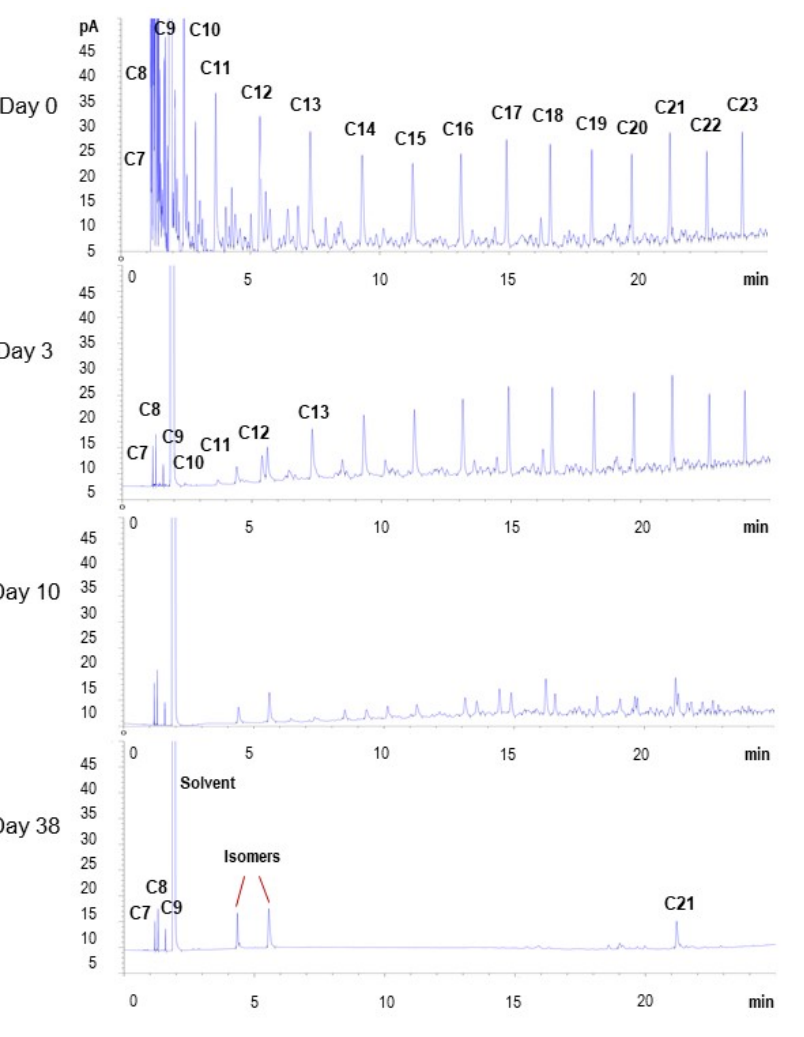
Figure 5. GC-FID chromatograms of Arab Light degradation by Bacillus licheniformis . C7–C12 aliphatic alkanes are quickly degraded. Residual signals in the last chromatogram (day 38) are not significant in area value (<10 pA *s).